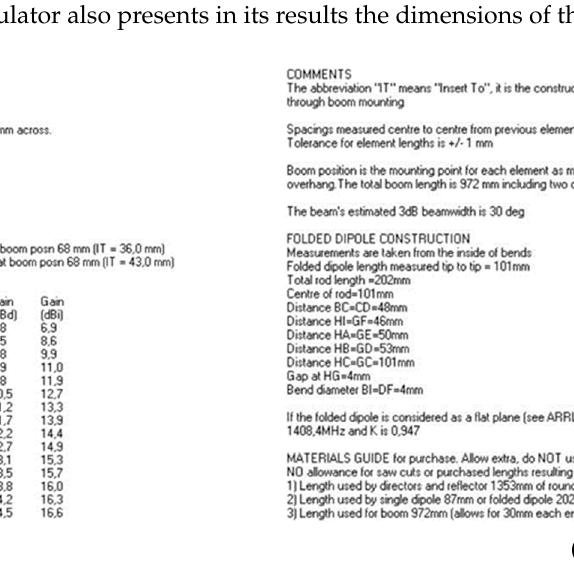
Figure 7. This are the results of a VK5DJ’s Yagi Calculator. ( a ) Yagi Antenna Sizing Results; ( b ) Results of folded dipole dimensions.